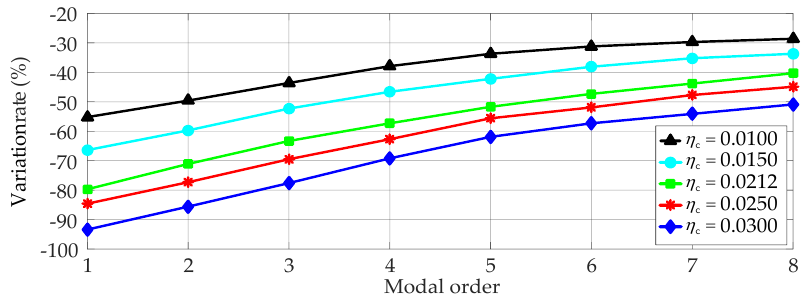
Figure 6. The variation rate of resonant response of the composite shell corresponding to different loss factors of hard coating.